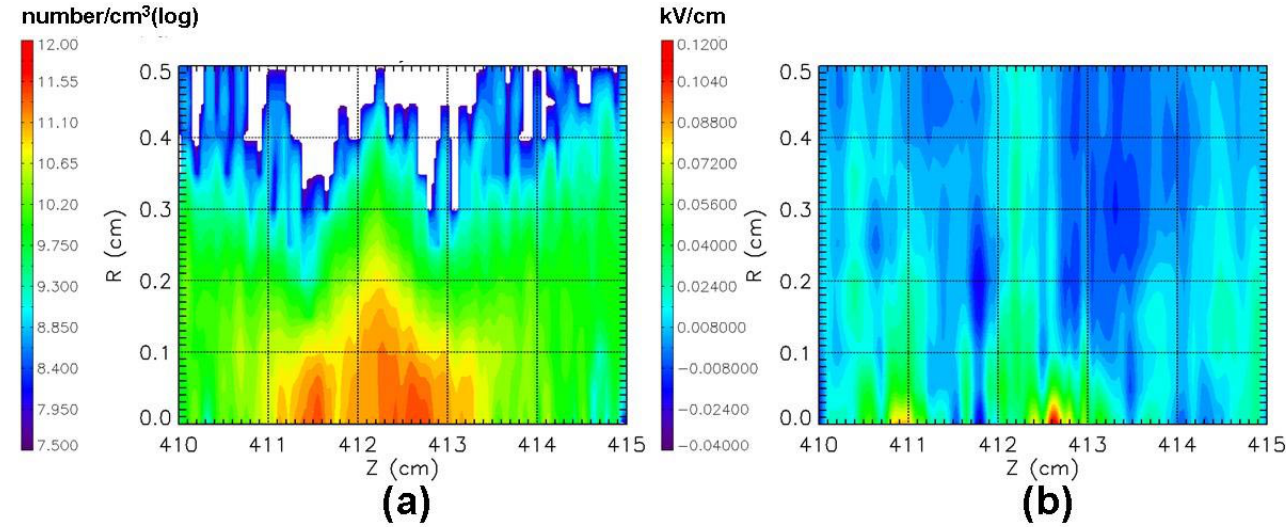
FIG. 6. (Color) The (a) beam density and (b) residual electrostatic potential are plotted just before peak compression (1900 ns) in the 10 10 - cm (cid:2) 3 density